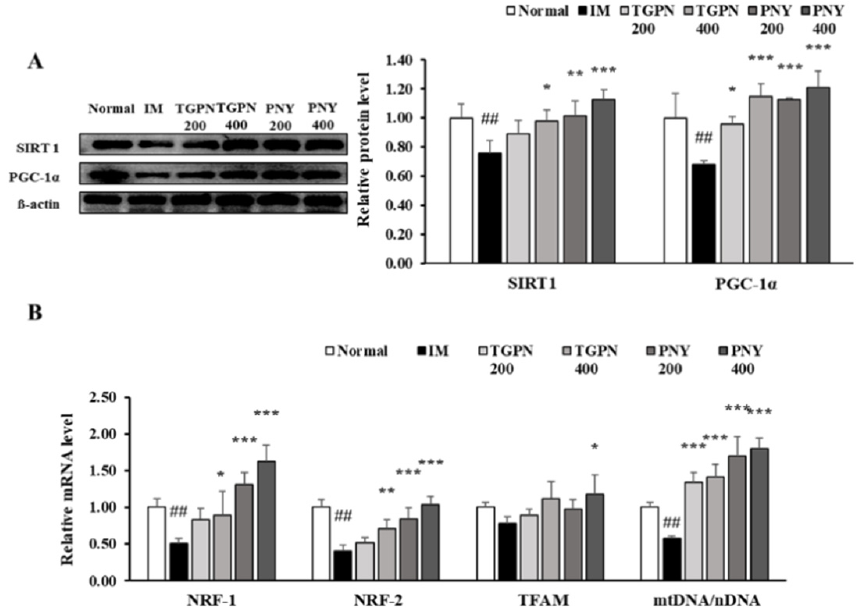
Figure 8. Effect of TGPN and PNY on mitochondrial biogenesis mechanism in gastrocnemius muscle. Mice were subjected to hindlimb immobilization for one week, except for the normal group, and then administered with TGPN 200, 400 mg/kg, or PNY 200, 400 mg/kg for two weeks with continuous immobilization. ( A ) Relative protein levels of SIRT1 and PGC-1 α . They were normalized to the β -actin level. ( B ) Relative mRNA levels of NRF-1, NRF-2 TFAM , and mtDNA contents. The mtDNA content quantified by taking the ratio between mtDNA/nDNA. The mRNA expression level was normalized to GAPDH. The data are expressed as mean ± SD. ## p < 0.01 versus normal, * p < 0.05, ** p < 0.01, *** p < 0.001 versus